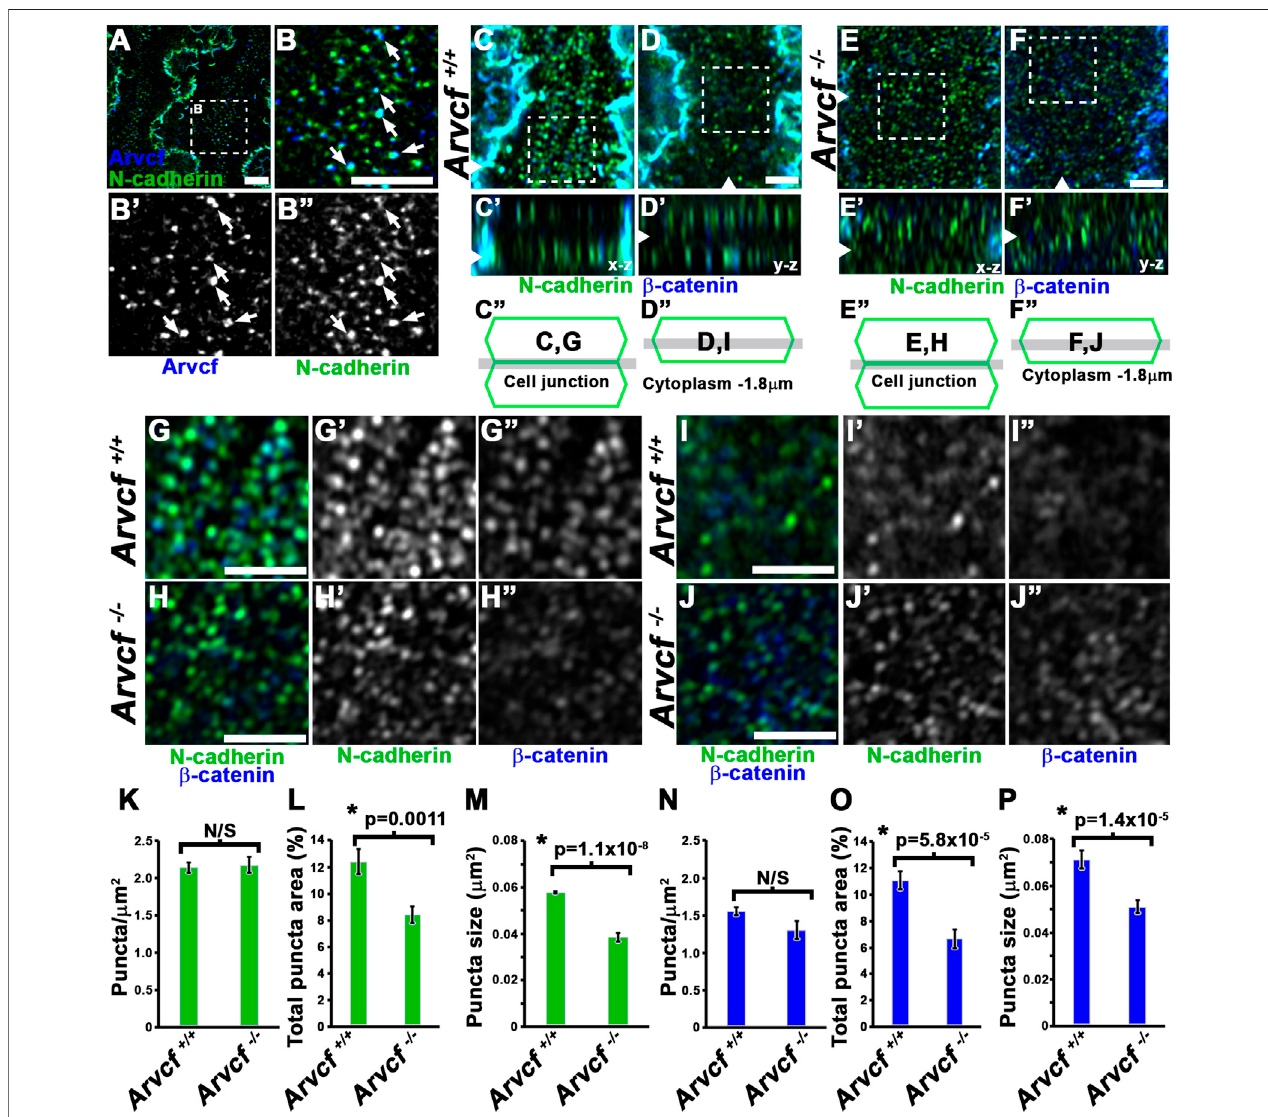
FIGURE 5| Arvcf isrequired for organization of N-cadherin and β -catenin in pAJs. (A – B) Whole lens fi ber cells immuno fl uorescently co-labeled for Arvcf (blue) and N-cadherin (green).The squared region in Ais the region magni fi ed in panel (B) . The arrows represent N-cadherin nanoclusters thatappear to be overlapping with Arvcf protein. Note that this is a common occurrence. (C – F) Whole lens fi ber cells from Arvcf +/+ (C – D) or Arvcf − / − (E – F) mice immuno fl uorescently co-labeled for β -catenin (blue)andN-cadherin(green)andimagedwhenfocusedonaz-planewithinthebicellularmembraneoftwoneighboringcells (C,E) orfocusedonaz-planethrough the cytoplasmofasingle fi ber cell~1.8 μ mfrom the membrane (D,F) . Note thatthe cytoplasmicsignal isrelatively lowin controlbut greaterin the mutant lens fi ber cells. (G – J) Magni fi ed regions outlined by the squared areas in (C – F) showing both the overlapping and individual signals. (K – P) Attributes including the density (K,N) , total areacoverage (L,O) ,and individualsize (M,P) ofN-cadherin (K – M) and β -catenin (N – P) punctawerequanti fi edfromimmuno fl uorescently labeled Arvcf +/+ and Arvcf − / − fi ber cells and their means and standard error are depicted in the corresponding graphs. The asterisks symbols represents a statistically signi fi cant difference from the control group ( p < 0.05). A Plan-Apochromat ×63/1.40 oil objective was utilized with a Zeiss Airyscan equipped microscope. All scalebars represent 2 microns.